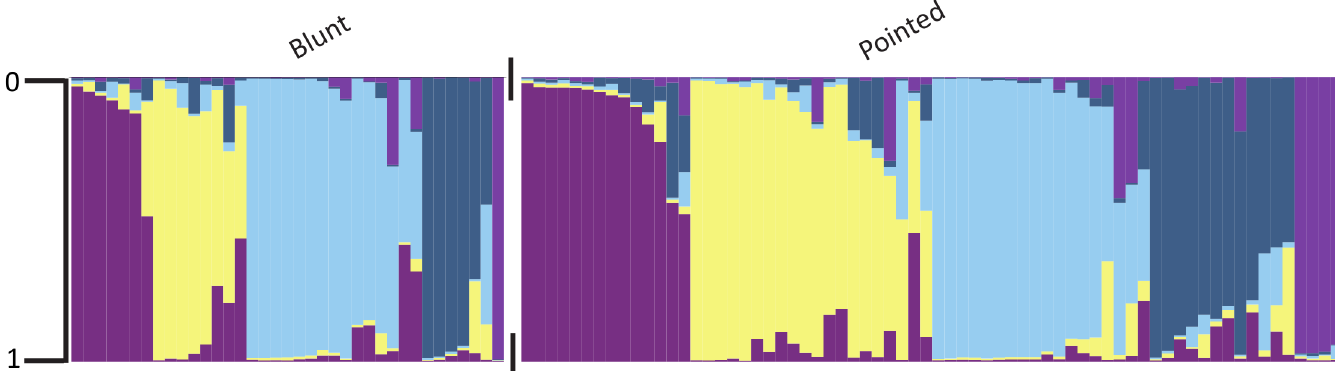
Fig 4. Population structure of pepper ( Capsicum annuum ) grouped by fruit end shape categories. Individuals are represented by their proportionate membership (0 to 1) in cluster 1 (purple), cluster 2 (light yellow), cluster 3 (sky blue), cluster 4 (steel blue), or cluster 5 (orchid). A white space and black tick marks separate subgroups of